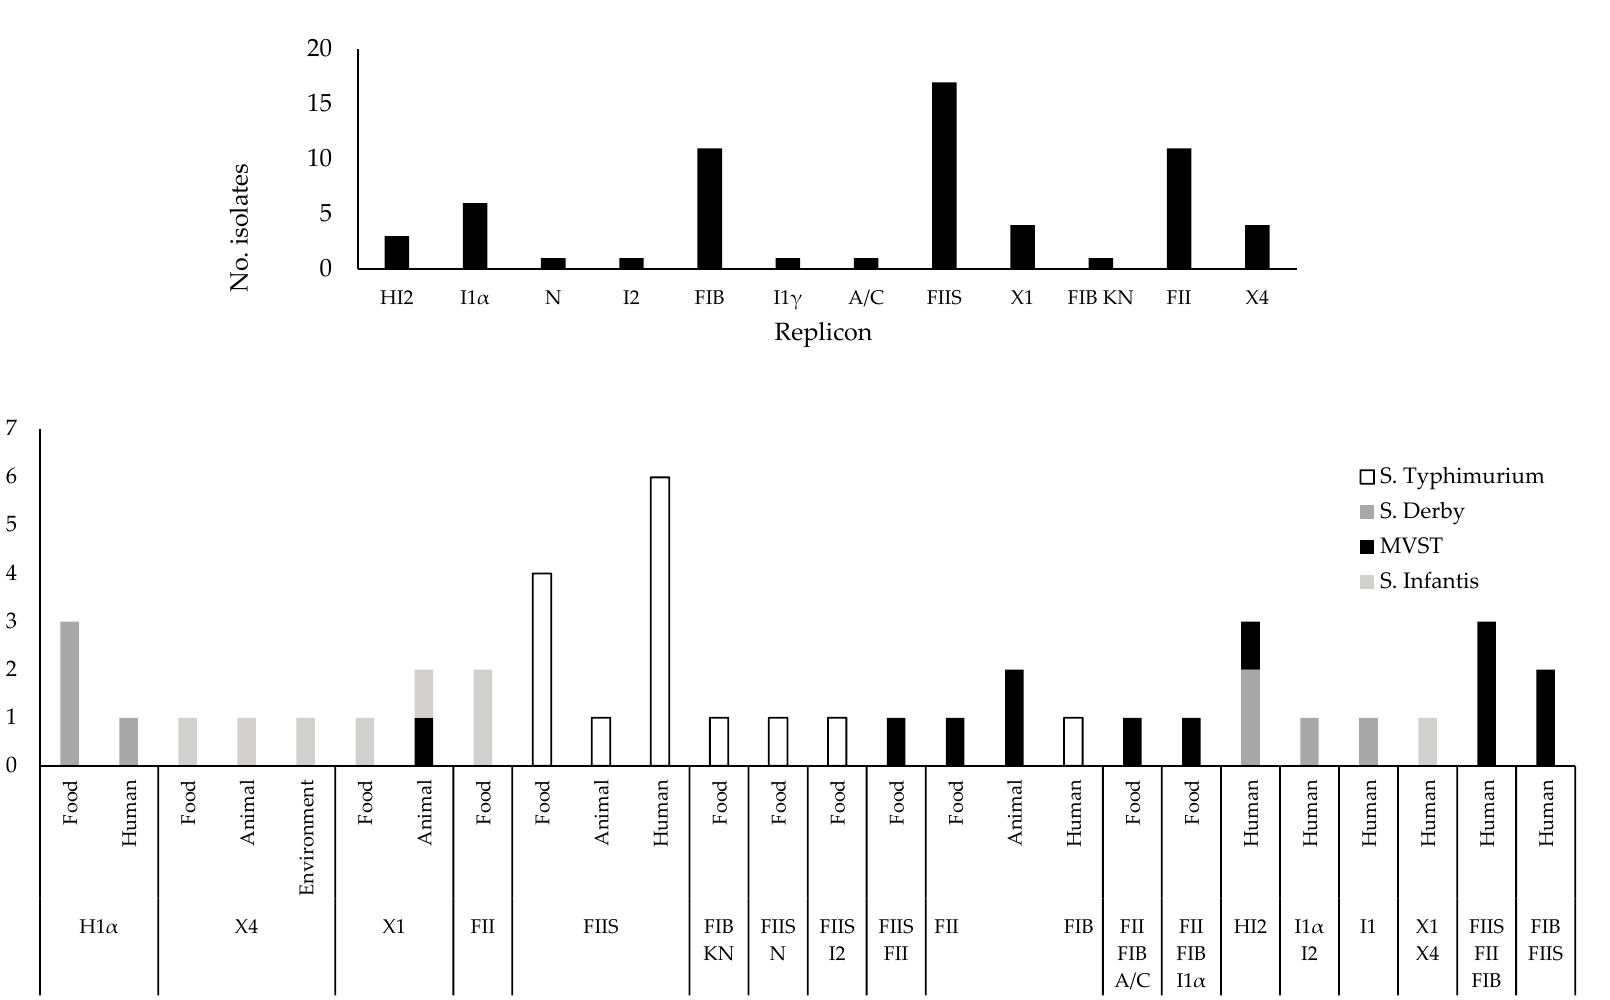
Figure 3. Replicons detected by PBRT and distribution of replicon patterns among Salmonella serovars isolated from different sources. ( A ) Replicons detected by PBRT. ( B ) Replicon patterns and distribution among the serovars of Salmonella strains isolated from different sources. MVST: monophasic variant of S . Typhi-murium.